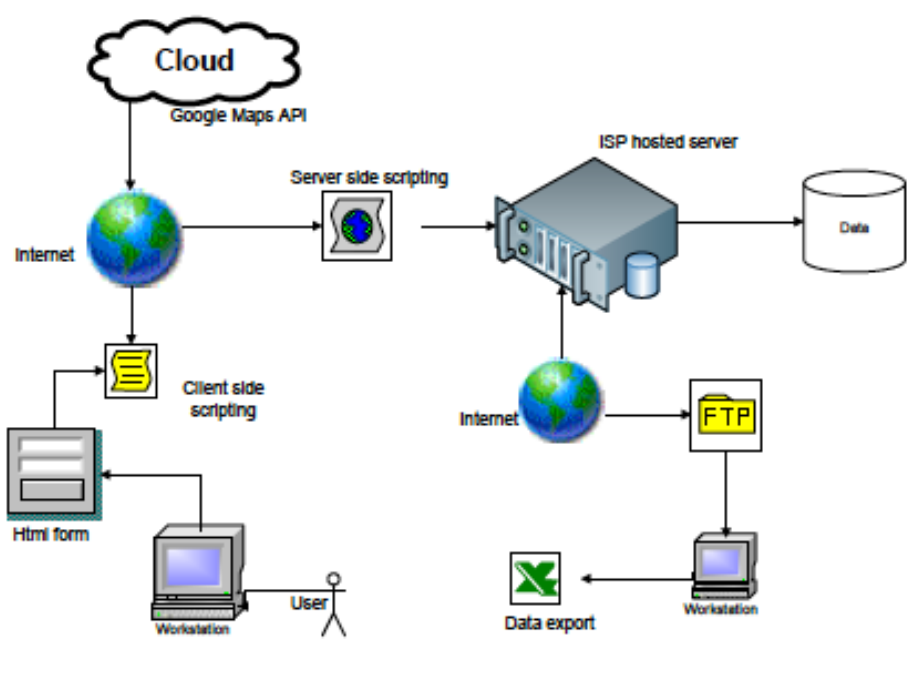
Figure 1. Outline of the Toad Tracker architecture.